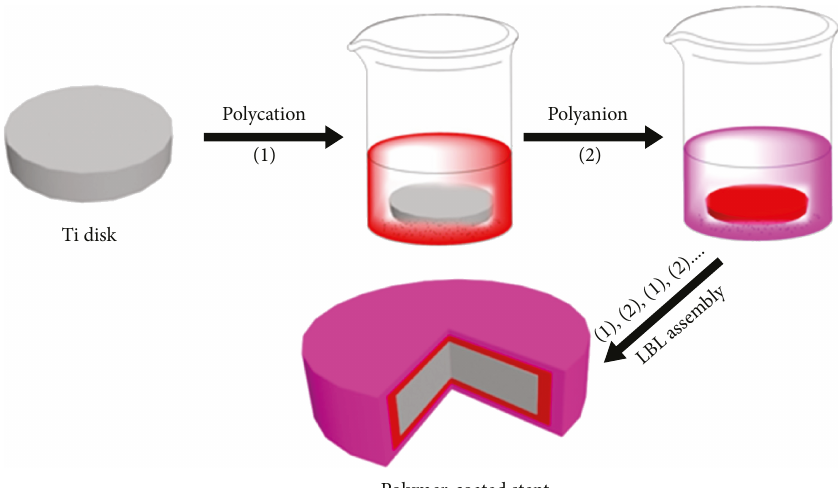
Figure 2: Scheme for the preparation of multilayers coating on substrate via layer-by-layer (LBL)